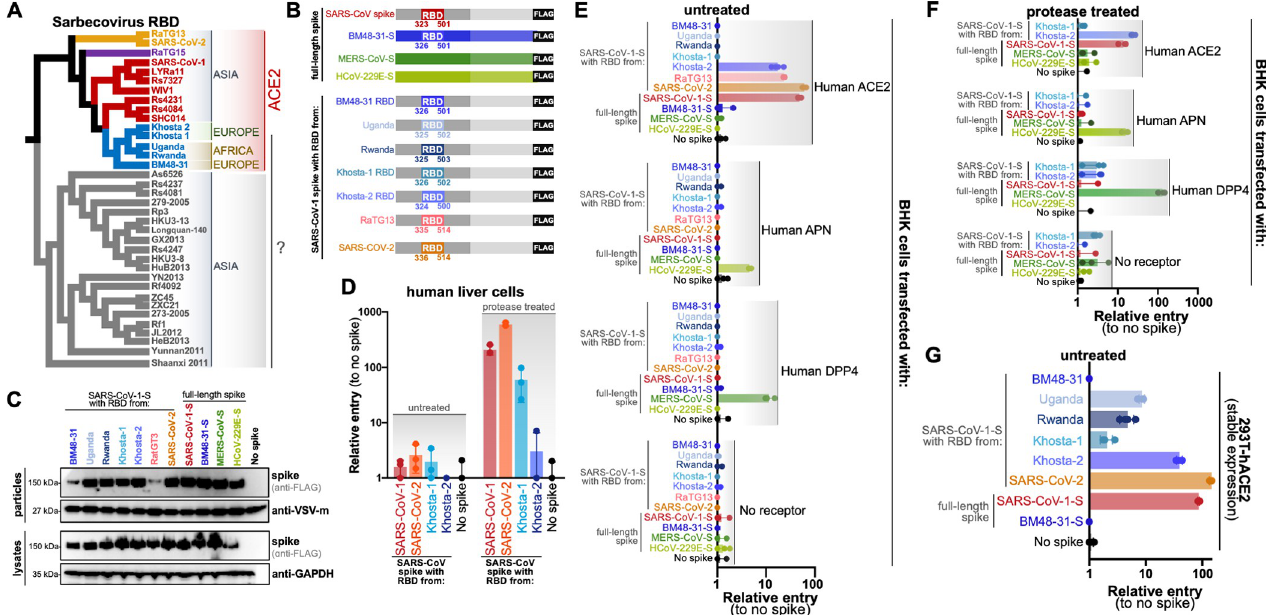
Fig 1. Khosta 2 and other RBD clade 3 sarbecoviruses use human ACE2 to infect cells. ( A ) Sarbecovirus Receptor Binding Domain Cladogram based on amino acid sequences and rooted at the midpoint. Countries of origin and known host receptors are indicated to the right. Clade 1 viruses are shown in red and orange, clade 2 in grey, clade 3 in blue and clade 4 in purple. ( B ) Diagram of spike constructs used for this study. The SARS-CoV-1 RBD was replaced with RBDs from other sarbecoviruses. ( C ) Expression and incorporation of viral pseudotypes by westernblot. ( D ) Huh-7 cells were infected with pseudotypes in the presence of absence of trypsin. Cells were infected in triplicate. ( E ) BHK cells were transfected with receptors and infected in the absence ( F ) or presence of trypsin. ( G ) 293T cells stably over-expressing human ACE2 were infected with pseudotypes without trypsin. Cells were infected in triplicate or quadruplicate for experiments in